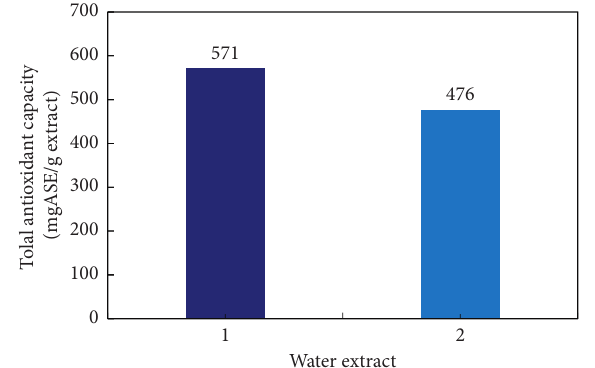
Figure 5: Total antioxidant capacity (mg ASE/g extract) of the aqueous grape pomace (1) and pomegranate peel (2) extracts were evaluated by the phosphomolybdenum method.